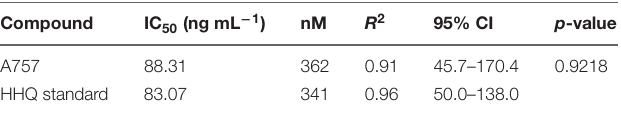
TABLE 1 | Statistical comparison of the dose-response curves and IC 50 values generated for Emiliania huxleyi (Strain 624) exposed to pure compound from A757 and the HHQ standard.